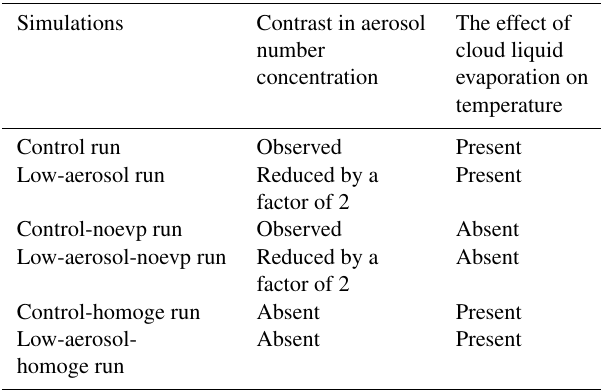
Table 1. Summary of simulations.